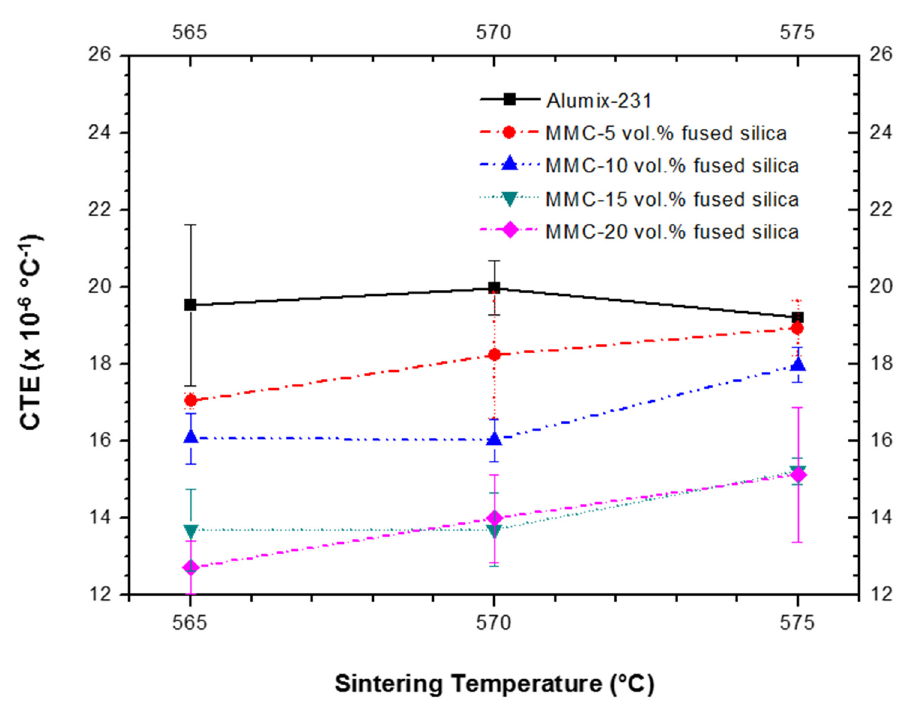
Figure 5. CTEs of neat Alumix-231 and MMCs versus sintering temperatures.